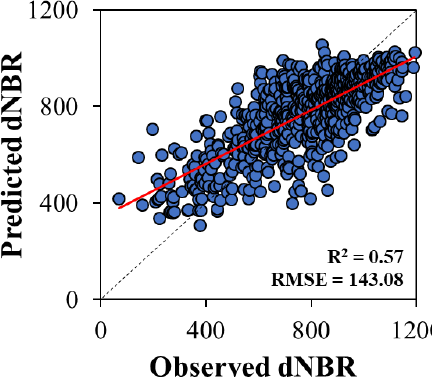
Figure 3. Relationship between observed and predicted fire severity (dNBR) using the Random Forest (RF) regression algorithm. The dotted line represents the 1:1 line, and the solid line is the fit of the linear model.